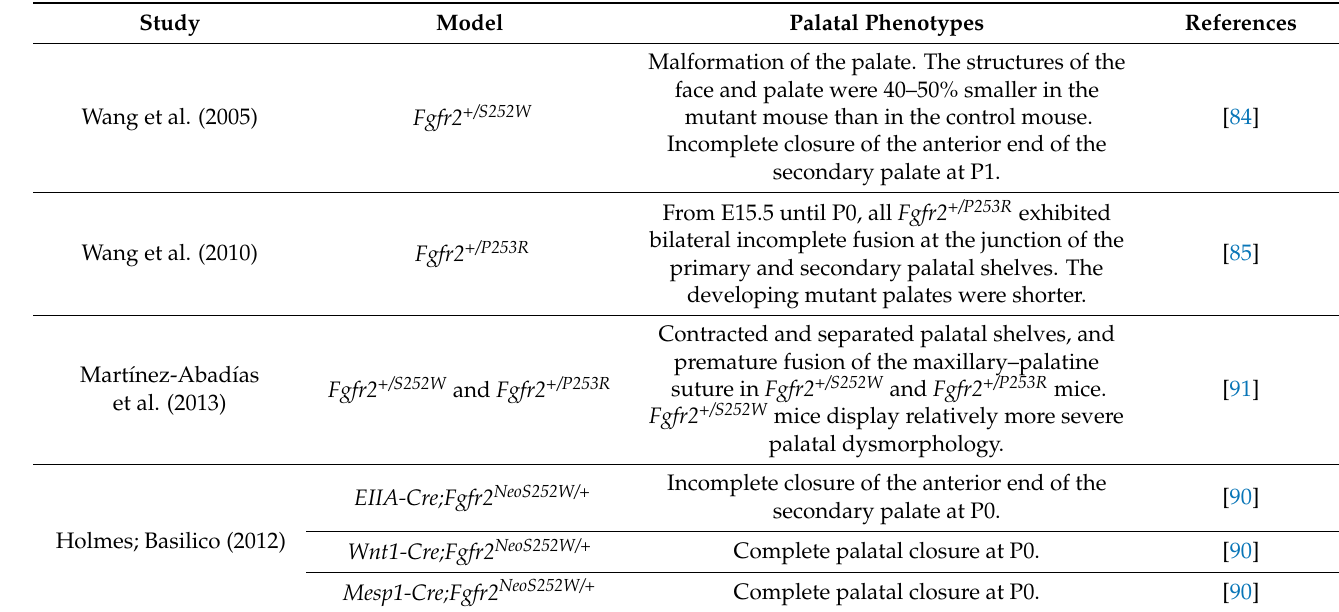
Table 4. Palatal phenotypes in Apert syndrome-related mouse